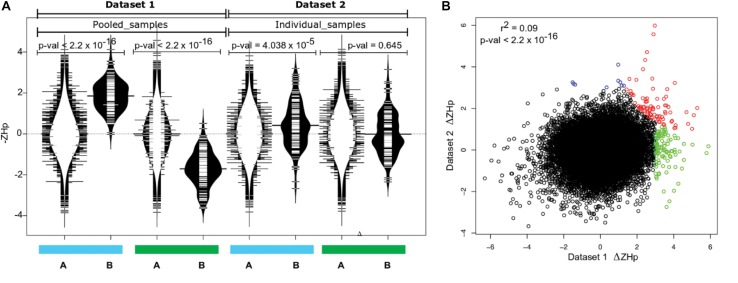
Common signals of selection in two independent datasets. (A) Putative selection sweeps in farmed fish from Dataset 1 (139 regions p-val < 0.001) contain higher fixation than expected in farmed but not in wild individuals in Dataset 2. The blue and green bars denote farmed and wild fish data respectively. The distribution of –ZHp values is shown for all windows genome wide (A, distribution plots with white interior) and separately only for the 139 windows putatively under selection in farmed salmon within Dataset 1 (B, distribution plots with black interior). (B) Correlation between ΔZHp for Dataset 1 and Dataset 2 identified genomic windows with outlier behavior in one or both datasets (r2 = 0.09; p-val < 2.2 × 10–16). Windows colored red denote significant positive ΔZHp in both Dataset 1 and Dataset 2 (Supplementary Table S7). Green windows were significantly positive only within Dataset 1 and blue only within Dataset 2. Outliers with significantly negative ΔZHp were not colored but are listed in Supplementary Table S8.